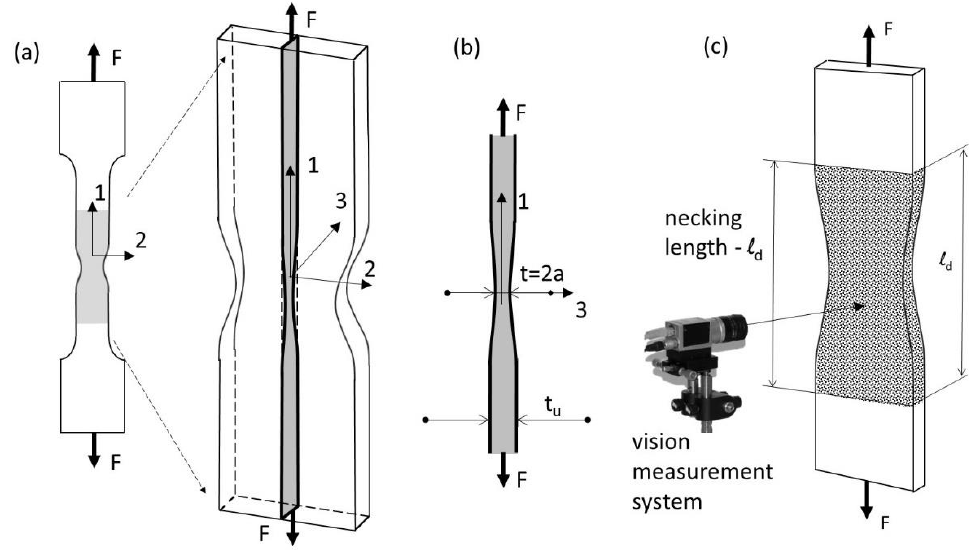
Figure 3. Uniaxial tension test. ( a ) plane strain model for necking, ( b ) the cross-section represent thickness of the sample, ( c ) schematic diagram of the vision measurement.